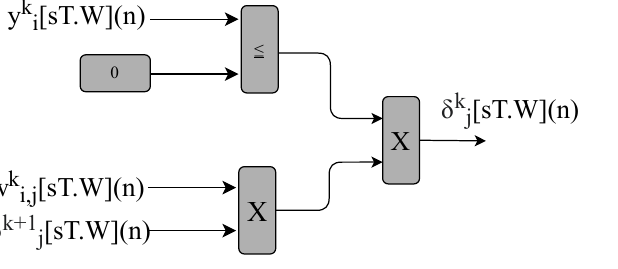
Figure 14. Block diagram representing the circuits used to obtain the hidden layers gradient implemented in the BPM module for the MLP-BP and RMLP-BP.